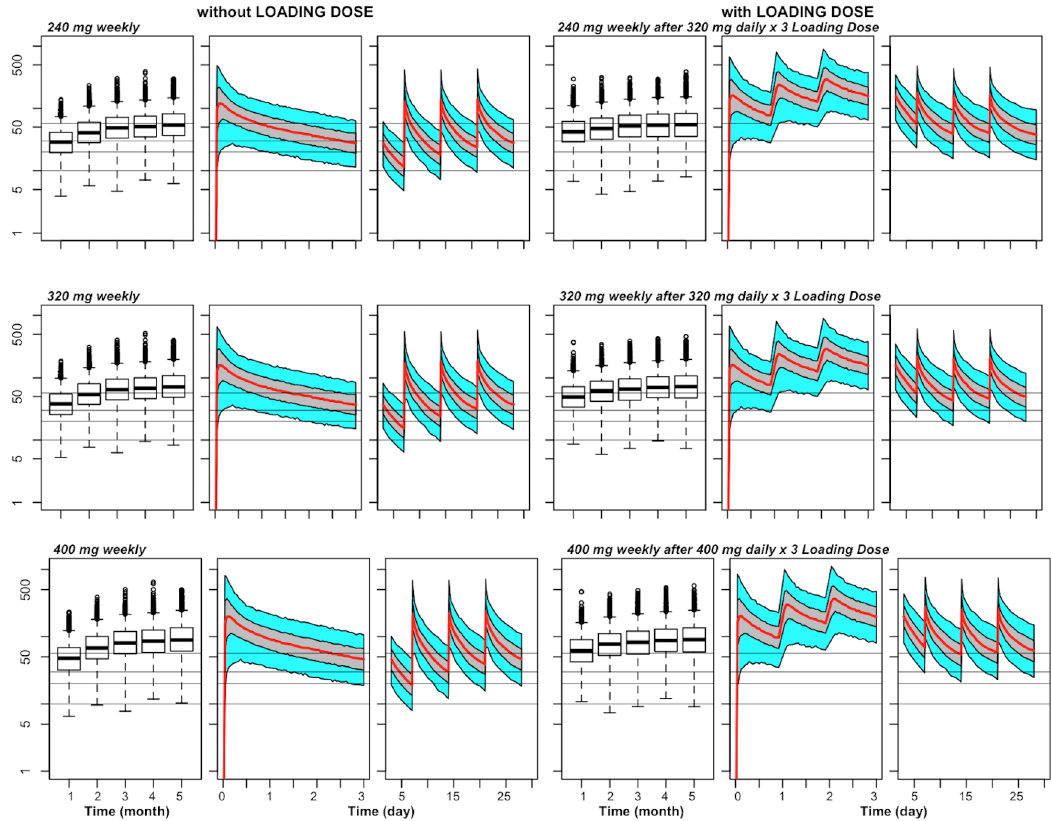
Fig 2. Predicted capillary plasma PQ concentration versus time for different doses of weekly chemoprevention regimens of DP without and with a loading dose in 1 – 2 year olds weighing (cid:4) 11 kg. For each combination of dose (240 mg, 320 mg, or 400 mg given weekly) and presence or absence of a loading dose, there is a set of 3 panels, with the left panel (box plots) showing trough concentrations of the first 5 months, the middle panel the PK profile during the first three days after the first dose, and the right panel the PK profile during days 3 – 28 relative to the first dose. For the PK profiles, the middle line represents the population predictions, the grey shaded area the 50% prediction interval and the outer bounds the 90% prediction interval. The grey horizontal lines indicate capillary plasma concentrations of 10, 20, and 30 ng/mL (for putative trough targets), and a capillary plasma level of 57 ng/mL (for a putative day 7